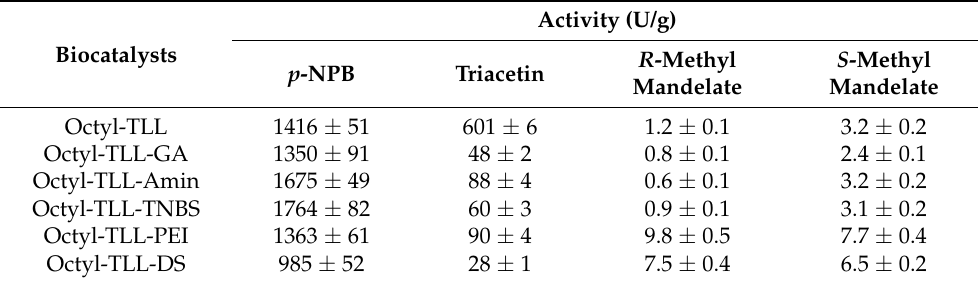
Table 1. Specific activity of different biocatalysts with 1 mM p -NPB (pH 7 and 25 ◦ C), 50 mM triacetin (pH 7 and 25 ◦ C), and 50 mM R - or S -methyl mandelate (pH 7 and 25 ◦ C). Experiments were conducted as described in